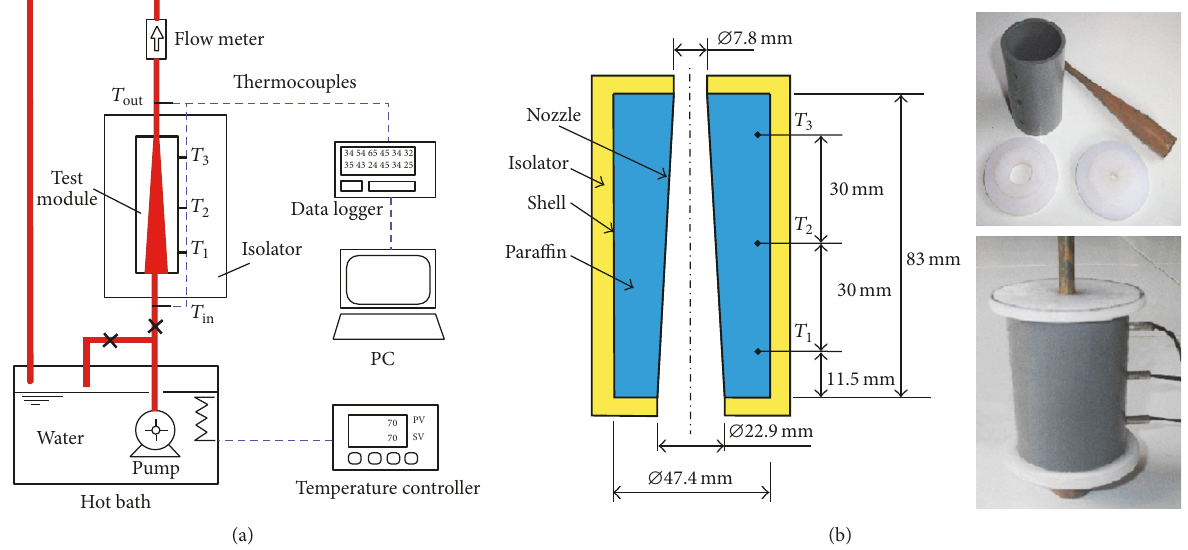
Figure 1: (a) Experimental set-up. (b) Detail of size and picture of nozzle-and-shell test module.